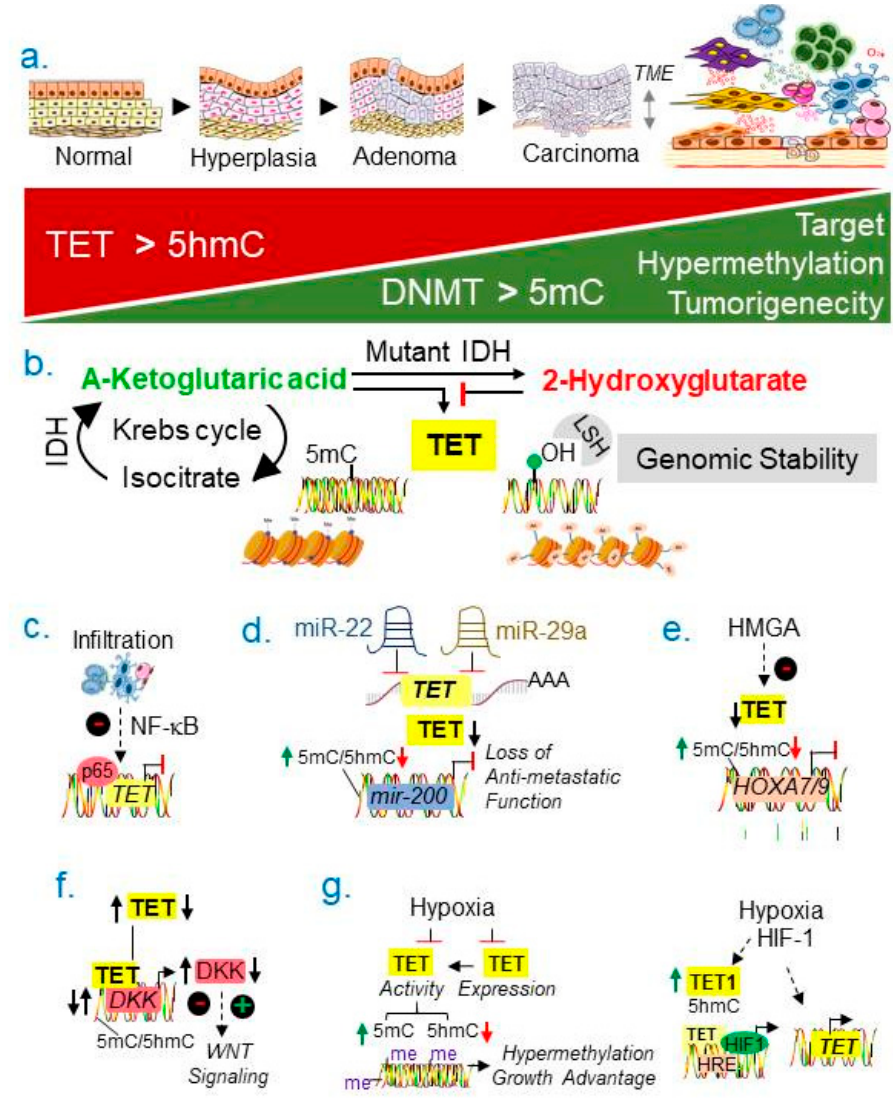
Figure 5. Breast cancer development and DNA-demethylation. ( a ) Illustrations showing breast cancer development and breast cancer—tumor microenvironment (TME) interactions. See Supplementary Figure S1 for description of TME. Reduced levels of TETs and 5hmC and increased levels of DNMT and 5mC in aggressive breast cancer. ( b ) TET activity regulation by ketoglutarate ( α -KG) and 2-hydroxyglutarate (2-HG). ( c ) Inflammation regulation of TET activity, ( d ) MicroRNA regulation of TET expression and function. ( e ) HMGA regulation of HOXA7 / 9 via TET. ( f ) TET regulation of WNT signaling via DKK. ( g ) Left, hypoxia regulation of TET activity and expression; Right, hypoxia regulation of HIF1-alpha-regulated genes.